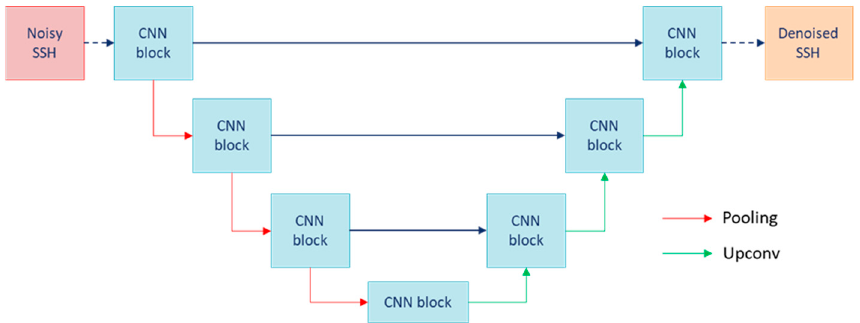
Figure 2. Architecture of the U-Net used for removing the KaRIn noise from a SSH fi eld.